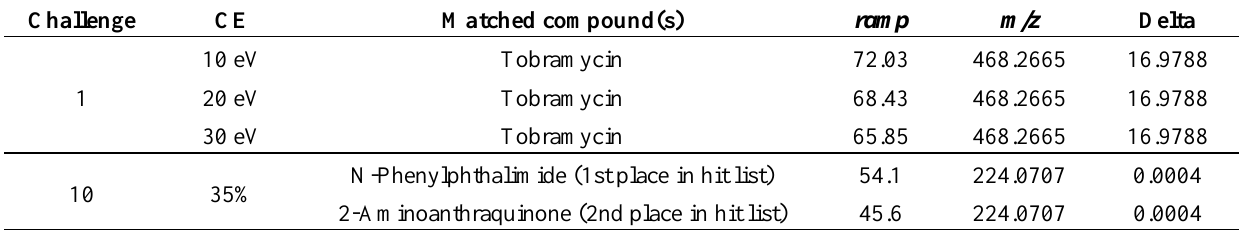
Table 4. Putative identifications with the Wiley Registry MS/MS. Unless otherwise stated, information on the best matching compound only is provided.